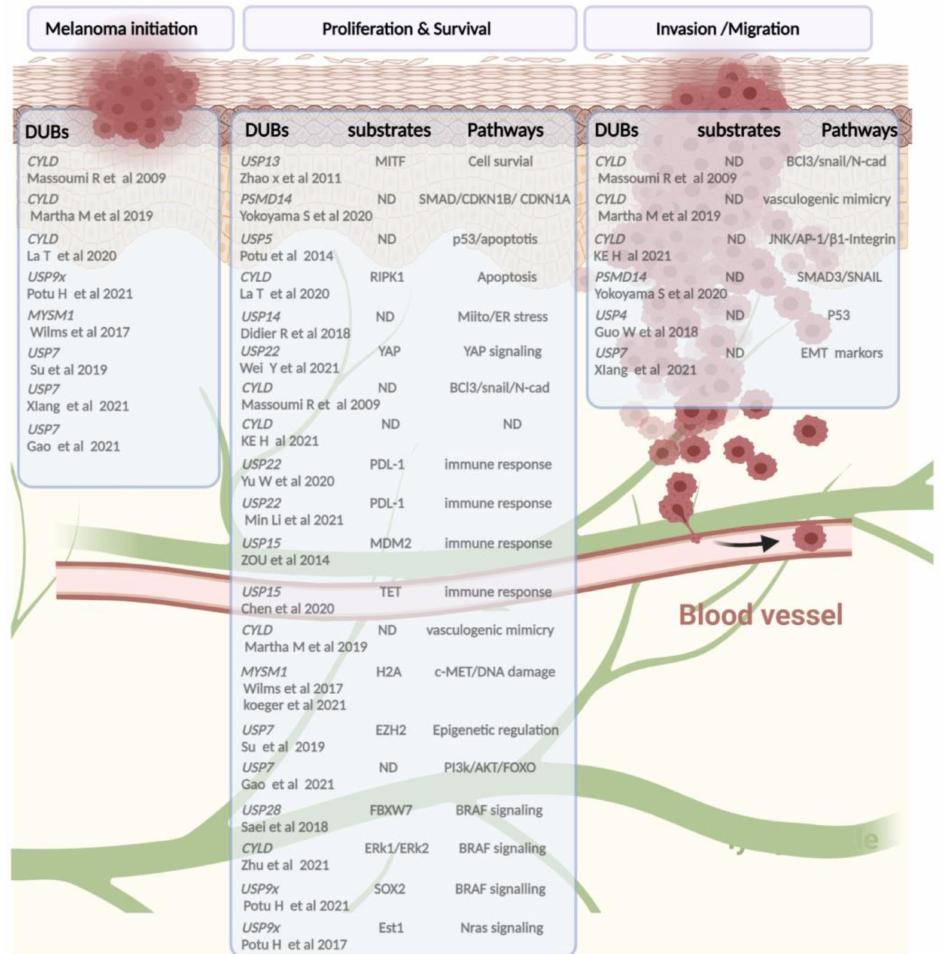
Figure 3. A schematic snapshot of deubiquitinases involved in melanoma pathogenicity based on published studies. From left to right, the following categories are shown: DUBs implied in tumor initiation or progression, mainly found in vivo studies, followed by a list of DUBs and their substrates and/or signaling pathways leading (in bold) to alteration of the proliferation, therapeutic response adaptation, and invasion/migration processes of melanoma cells. (Created with BioRender.com, accessed on 20 June